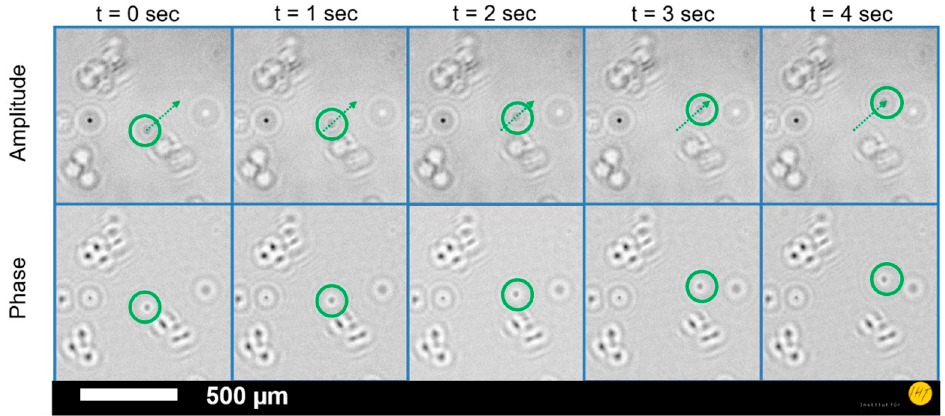
Figure 3. Time-series (1 s step) of cell culture images, in which both amplitude and phase contrast figures show the movement of a mouse astrocyte cell detached from the culture container